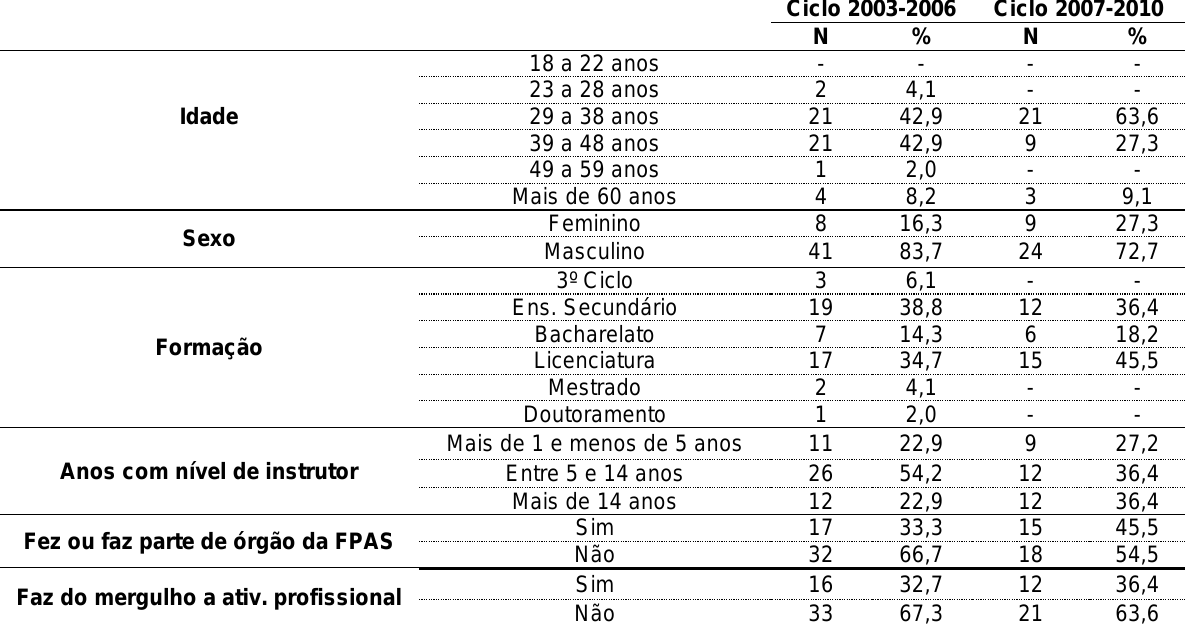
Tabela 1. Caracterização da